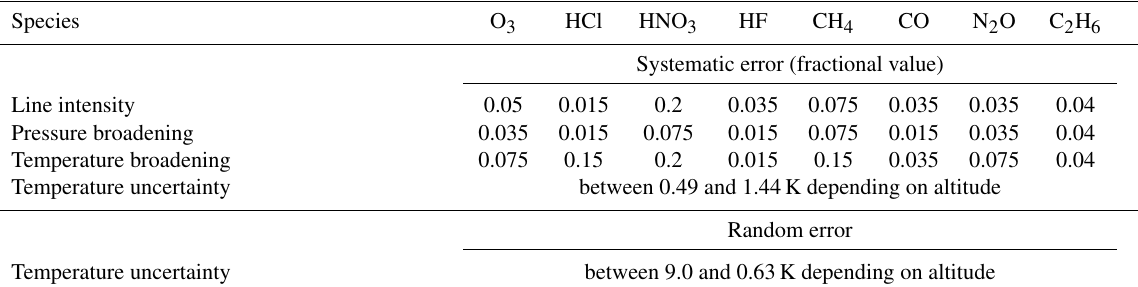
Table 2. Inputs used for the error budget to estimate the total retrieval uncertainties. The line width error (discussed in the text) is the combined uncertainty of the pressure and temperature broadening. The same uncertainties have been used to estimate the errors for PARIS- IR and the Bruker 125HR, with the exception of the SZA that is dependent on the measurement duration for each FTS. Details can be found in the